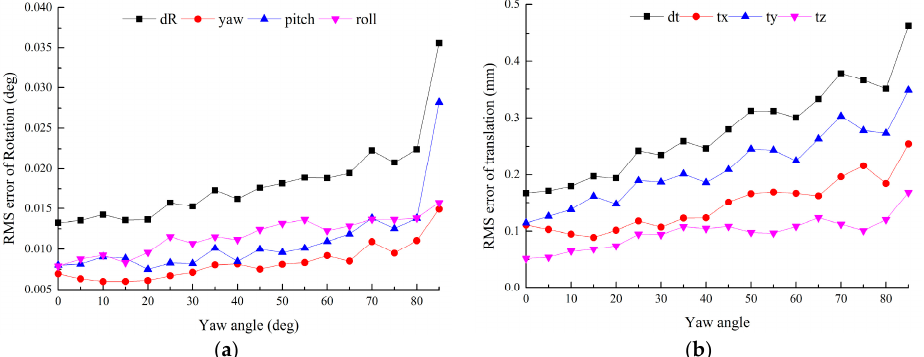
Figure 4. Error vs. the yaw angle difference between two adjacent targets: ( a ) RMS error of rotation vs. the yaw angle difference; ( b ) RMS error of translation vs. the yaw angle difference.